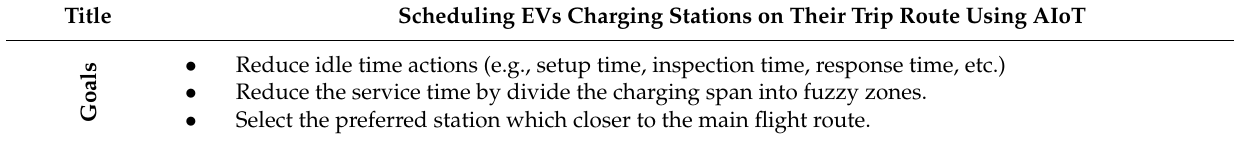
Table 1. The work charter design